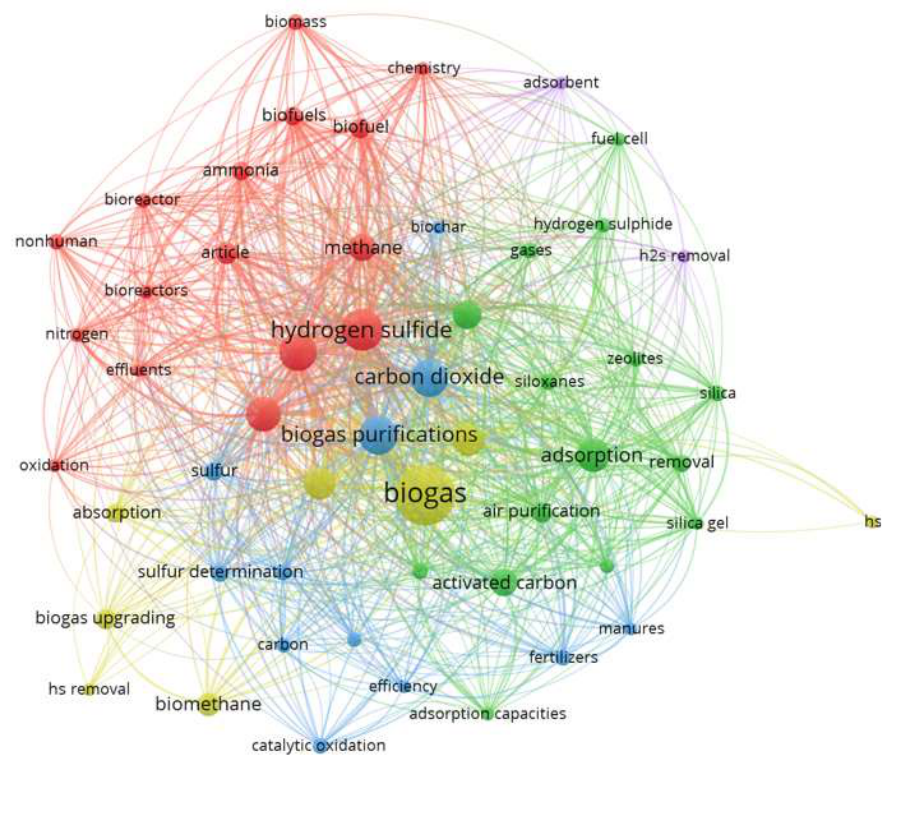
Figure 4. Main keywords.